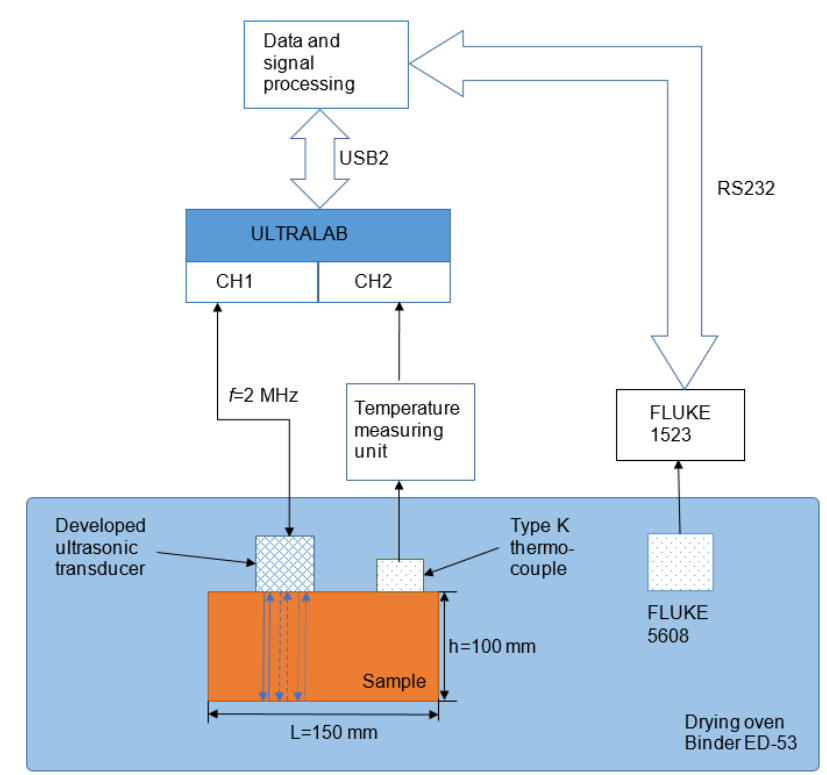
Figure 6. Set-up of experiment.